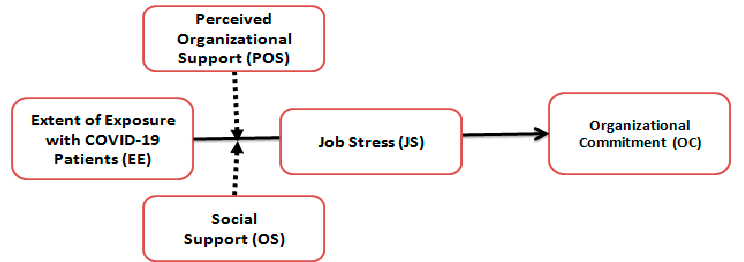
Figure 1. Conceptual framework.